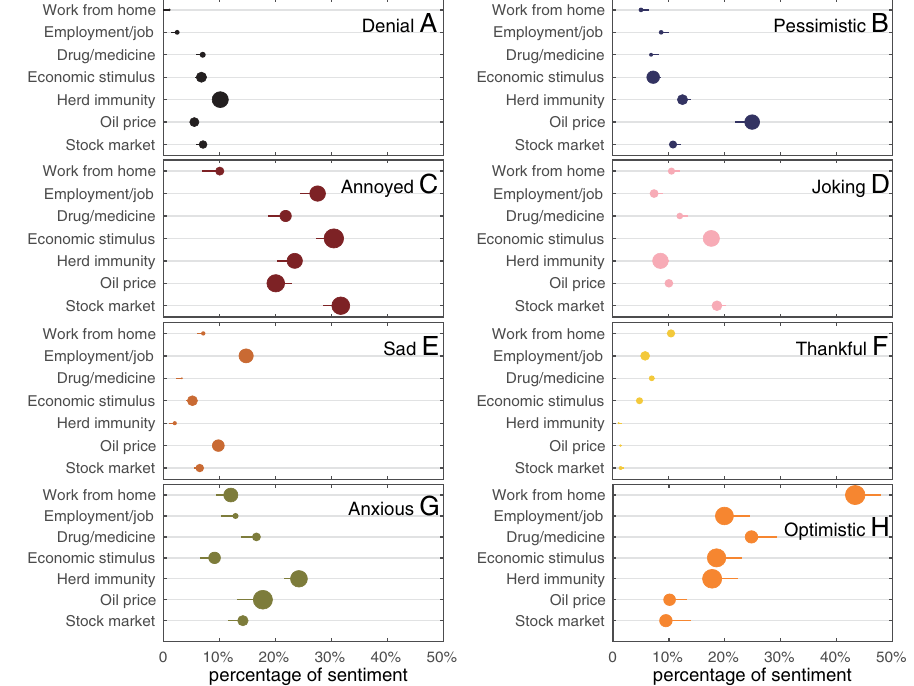
Fig. 5 Comparison of sentiment variations across conversation topics. A – H Mean of daily sentiment in each category under each topic, excluding empathetic because of its small value (at the 10 − 4 level) under all topics. Symbol size is proportional to the standard deviation (ampli fi ed by ten times to be visible), attached with a line indicating increase (pointing right) or decrease (pointing left) over time. The length of the line is proportional to the steepness of the linear line fi tting one sentiment curve over days, i.e., the slope in % per day (ampli fi ed by 60 times for